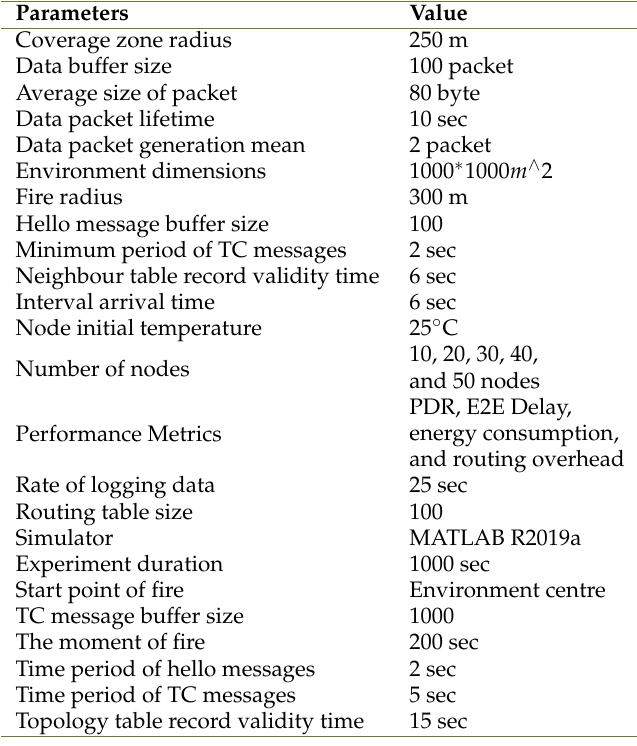
Table 1. The simulation